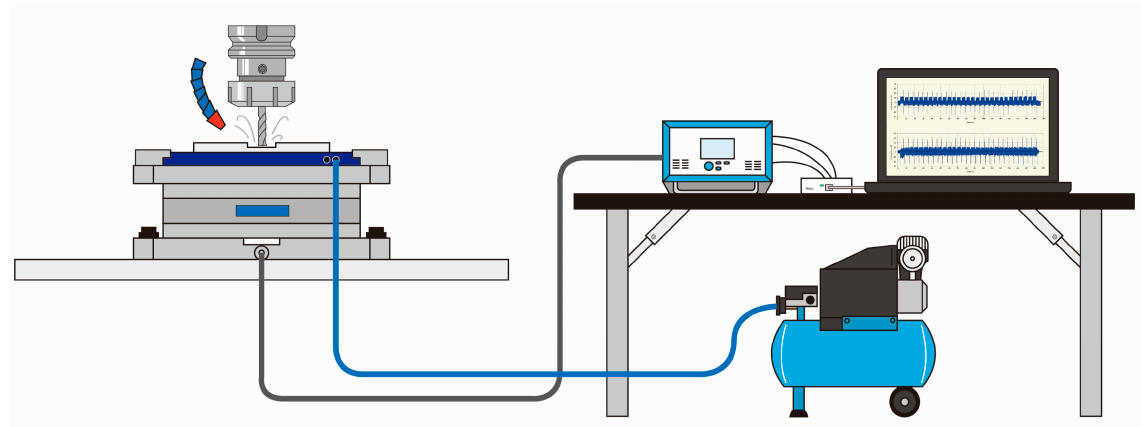
Figure 4. The measuring points.